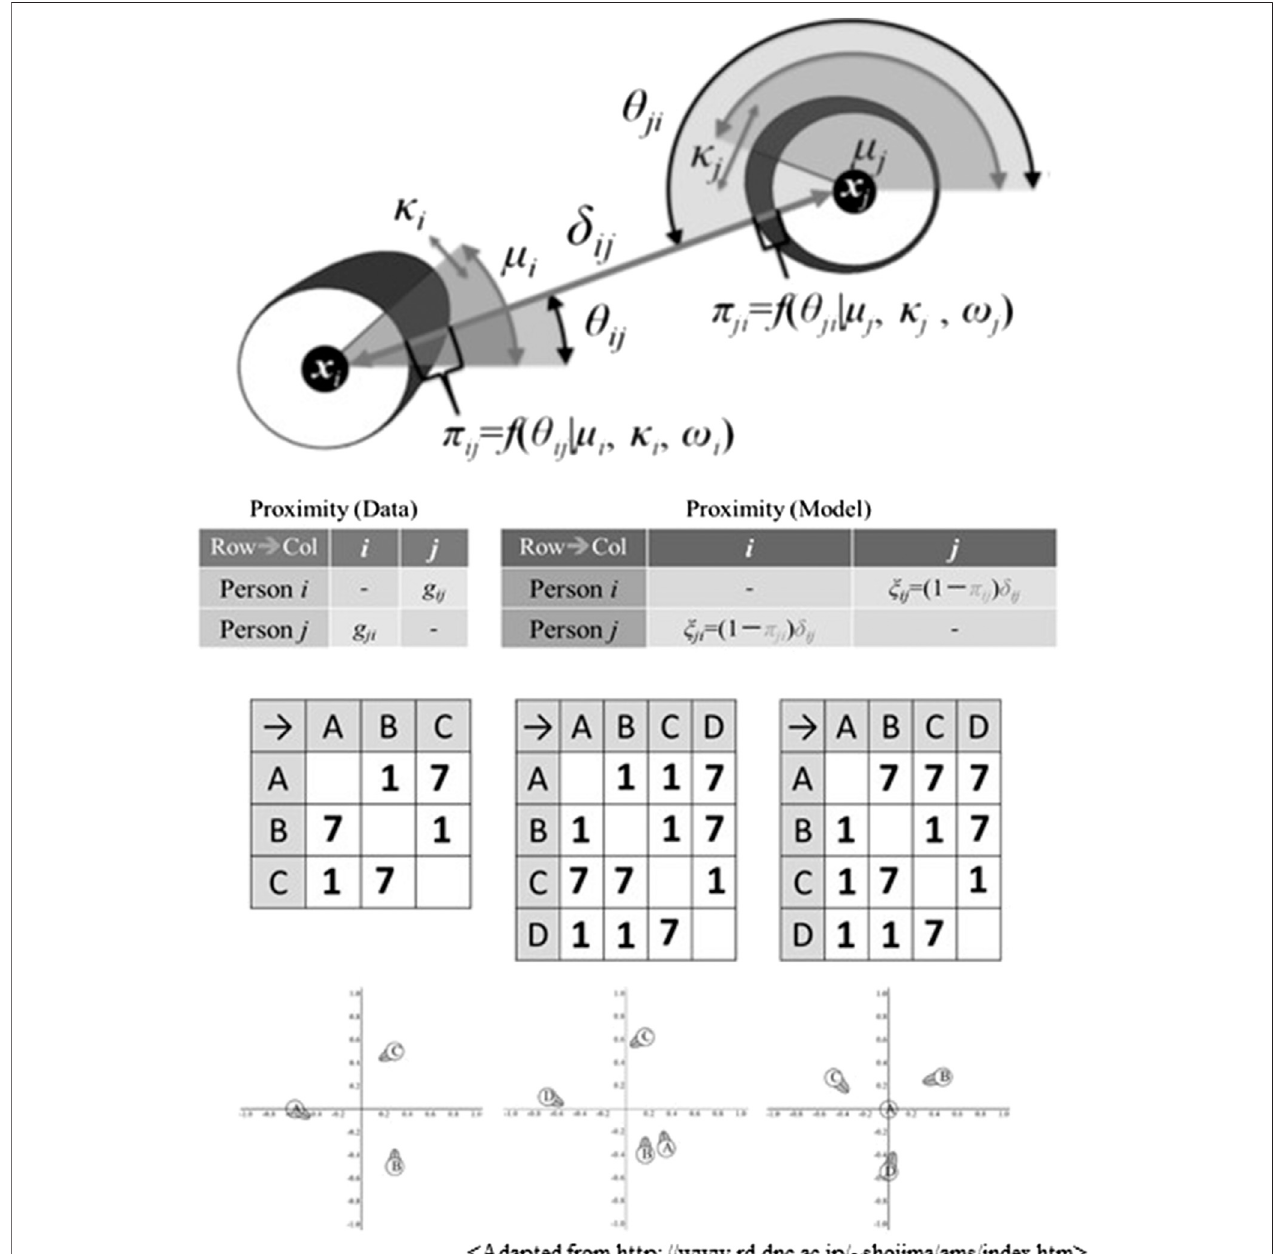
FIGURE 2 | Graphical representation of asymmentry in